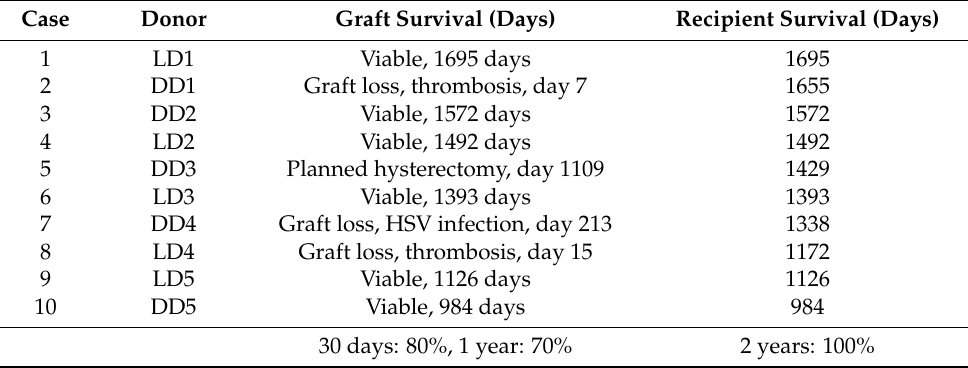
Table 5. Outcomes of 10 consecutive uterus transplantation grafts and